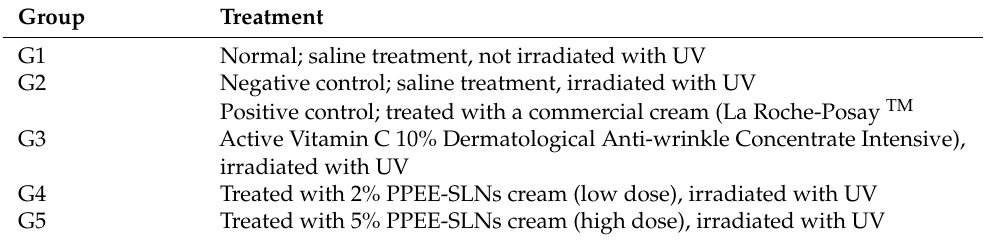
Table 2. The different groups of the experiment. Treatment was done three times weekly for 40